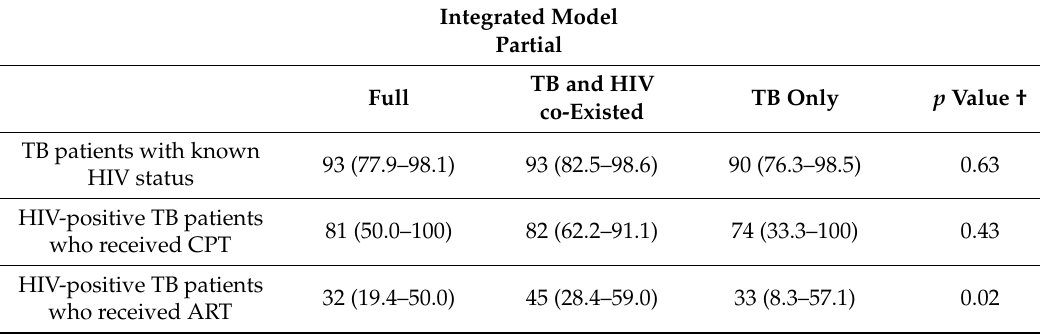
Table 3. Median (interquartile range (IQR)) percentage of target patients who received the specific service from government sector by different integrated models in